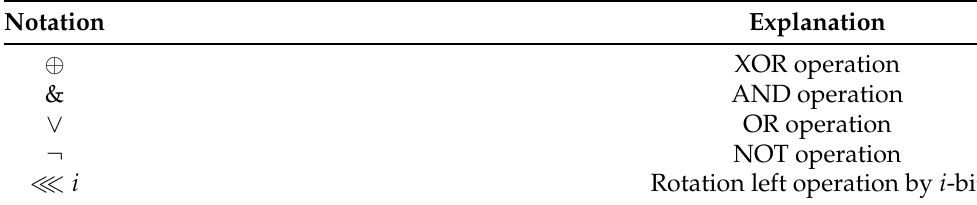
Table 1. Descriptions of notations in this